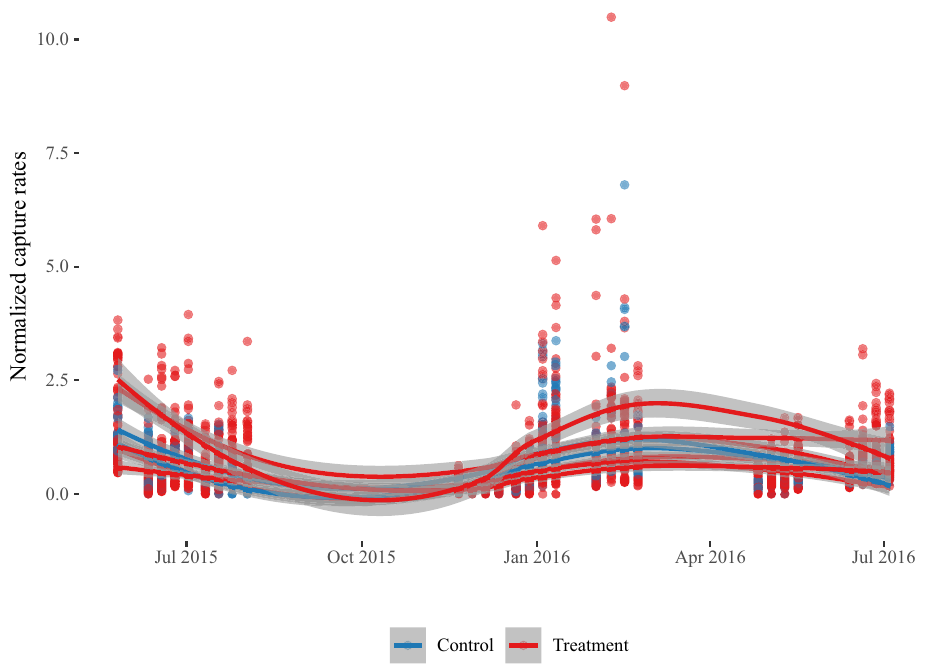
Figure 2. Normalized trap captures of B. dorsalis in Arba-Minch in control and treatment plots of smallholder orchards throughout the intervention period. Capture rates were expressed as a fraction of the average capture rates of that plot at the beginning of the intervention trial. Results are expressed as a square root transformed value. Local Polynomial Regression Fitting was used for smoothing the